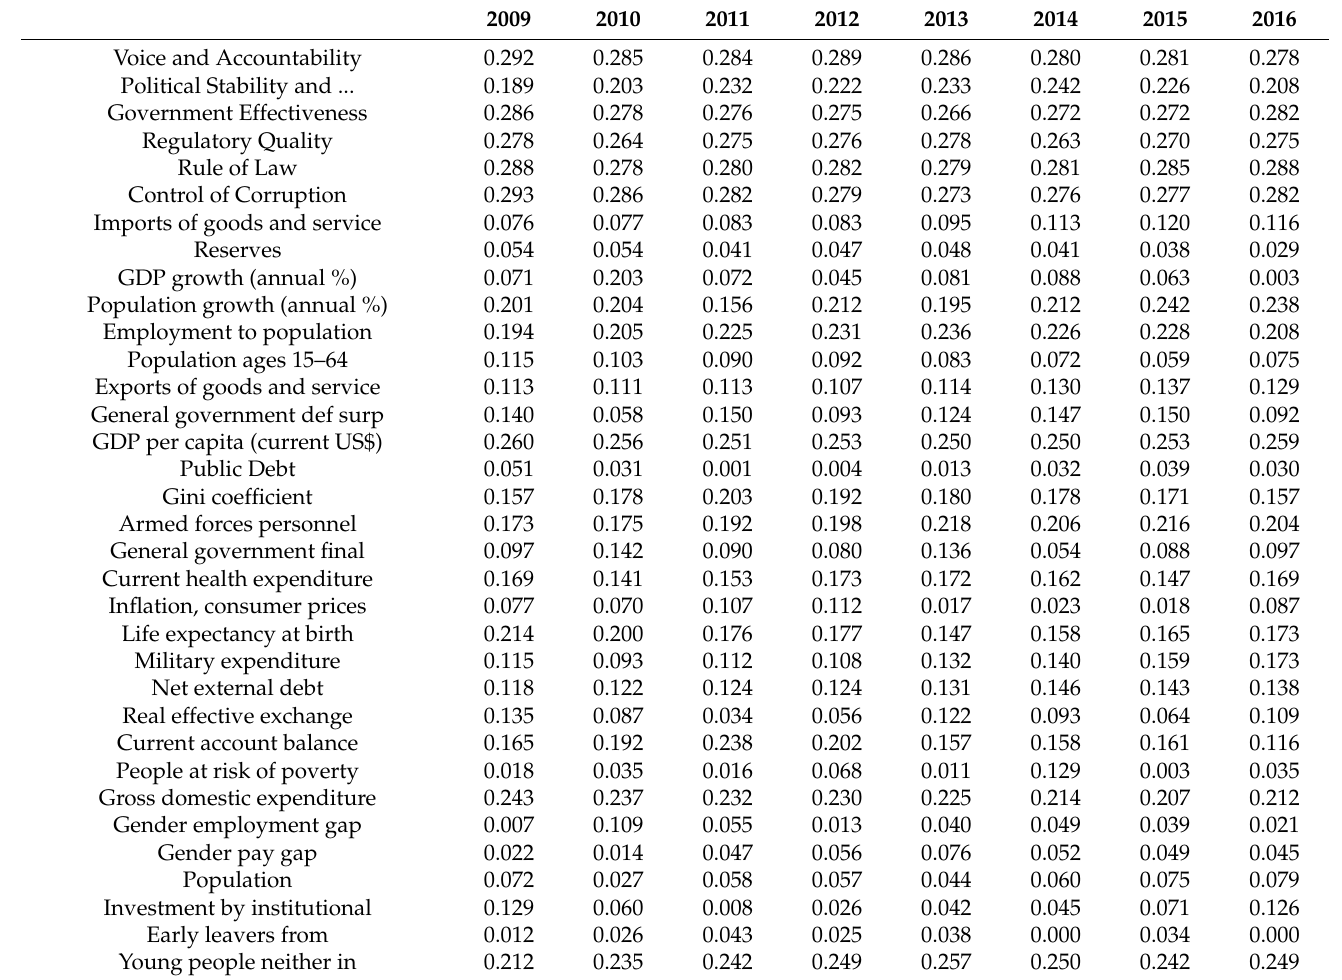
Table 1. Variables’ weights for each